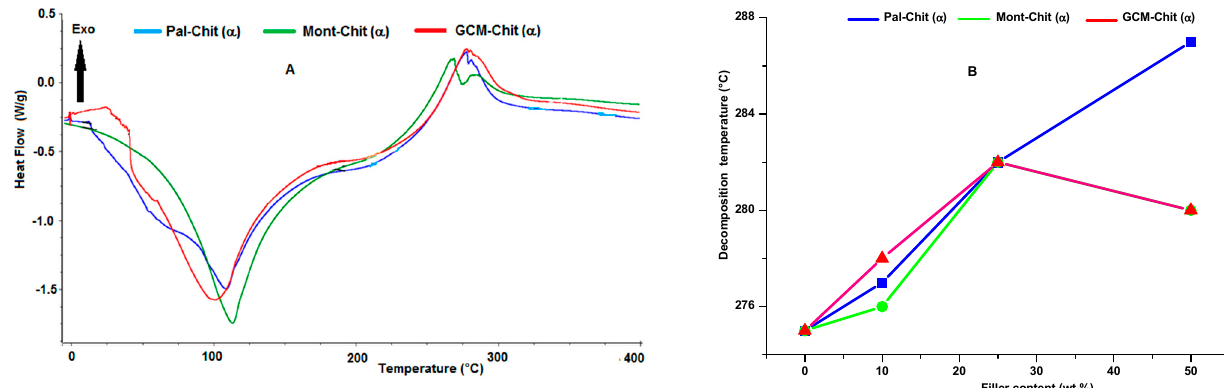
Figure 10. Thermograms of the α -chitosan-based films containing 10 wt.% of the fillers studied ( A ), and changes in the decomposition temperature of the α -chitosan-based films as a function of the filler contents ( B ). Chit: chitosan; Pal: palygorskite; Mont: montmorillonite; GCM: geopolymer-containing material.